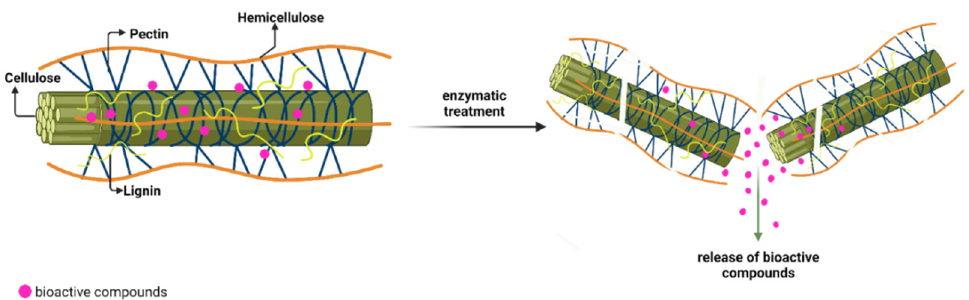
Figure 2. Illustration of bioactive compounds (phenolics) in the cell wall of plant structure. Protein is also a key nutrient that is discarded with cereal industrial waste such as BSG. A recent study by Rommi et al. [45] presented an alkaline protease treatment protocol aiming to remove BSG protein. Protease pretreatment enhances protein extraction yield from 15% to 100%, compared to the untreated BSG sample. Because of their properties and nutritional worth, lipids are also an important compound of food